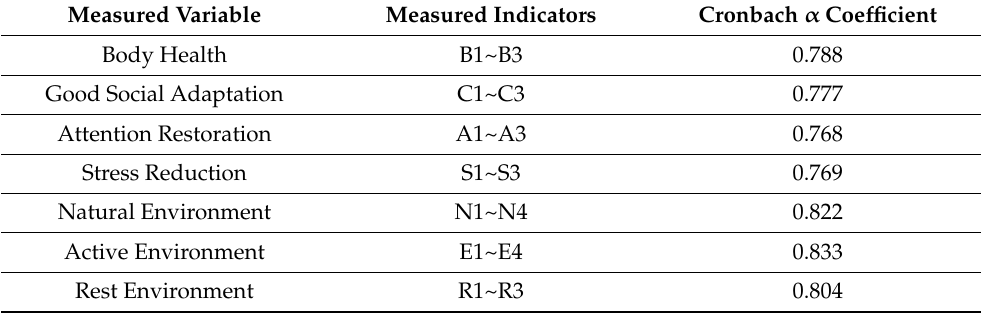
Table 5. Reliability test for questionnaire scale.